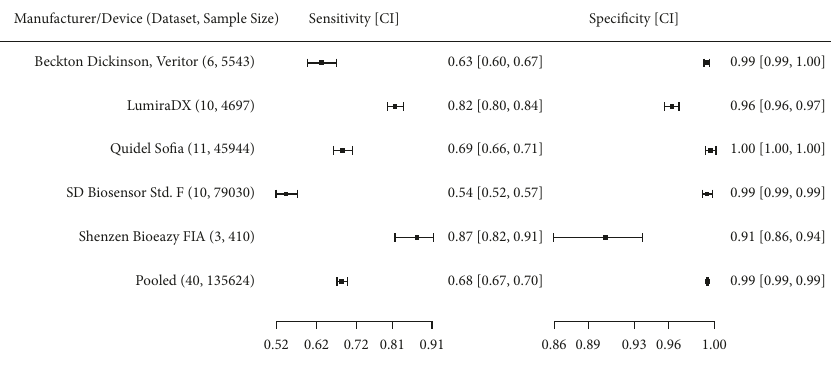
353.097, 95% CI: (cid:31)